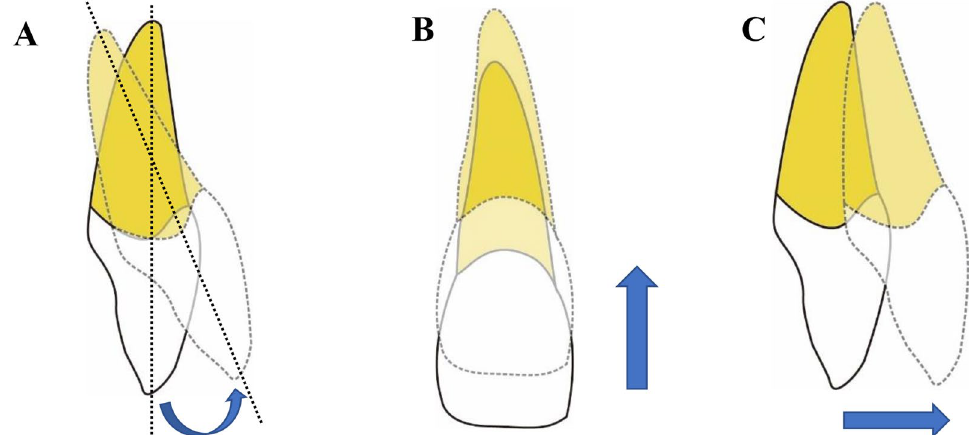
Fig. 4 Schematic plots of three types of tooth movement. A Proclination. B Intrusion. C Labial